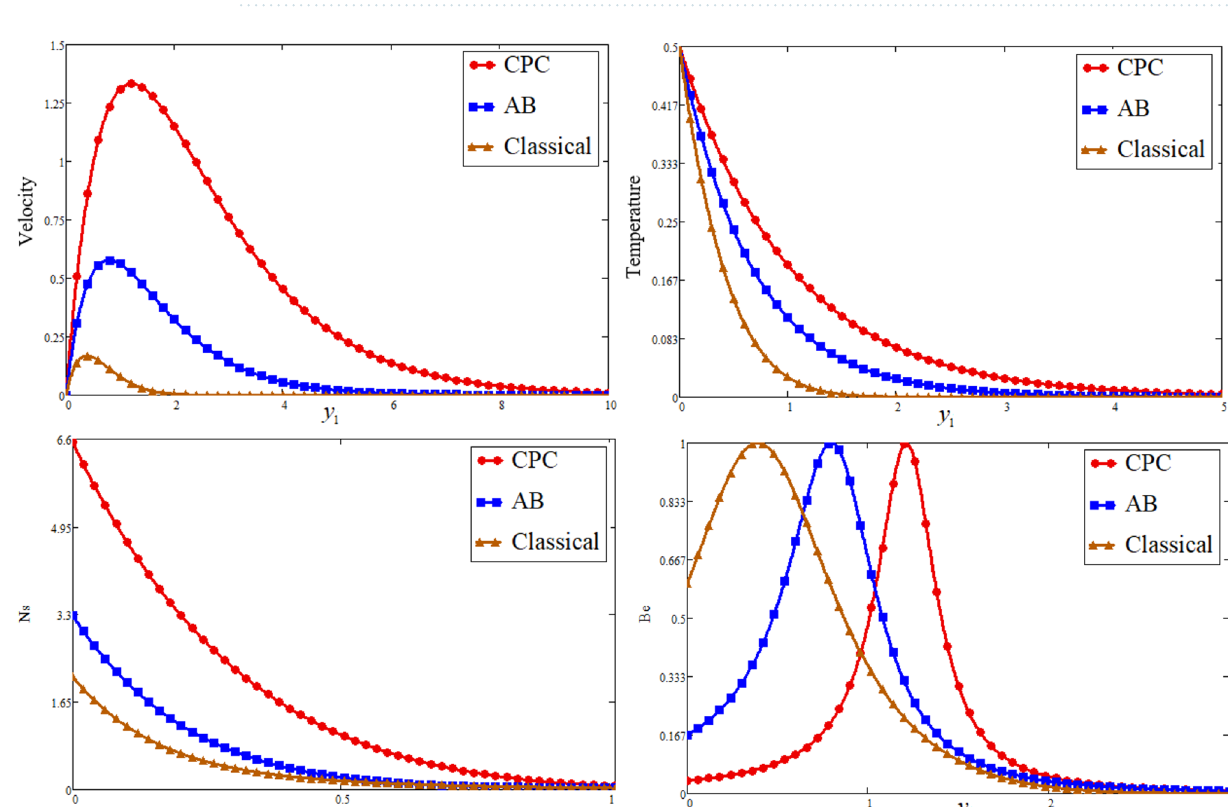
Figure 6. Comparative plot of Bejan number, entropy generation, temperature, and